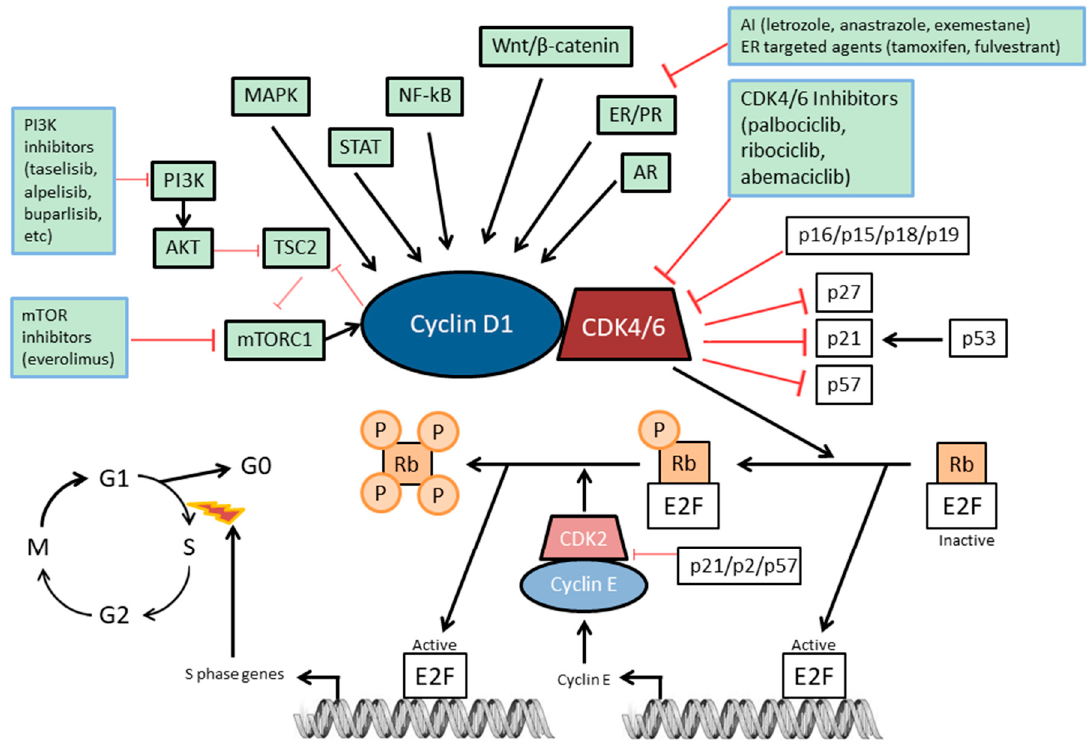
Figure 1. Cyclin D1–CDK4/6–Rb pathway in breast cancer. The molecular pathway and the major interconnected molecules are indicated. The inhibitory strategies that are most feasible in combination with CDK4/6 inhibition are indicated.